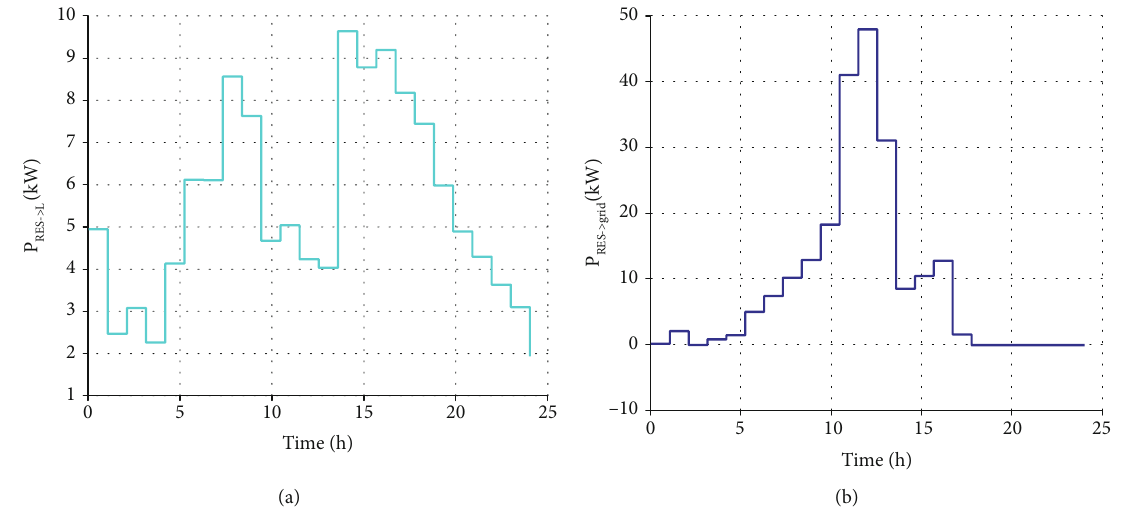
Figure 23: (a, b) Discharged power from RES to the load and grid by the hybrid algorithm,